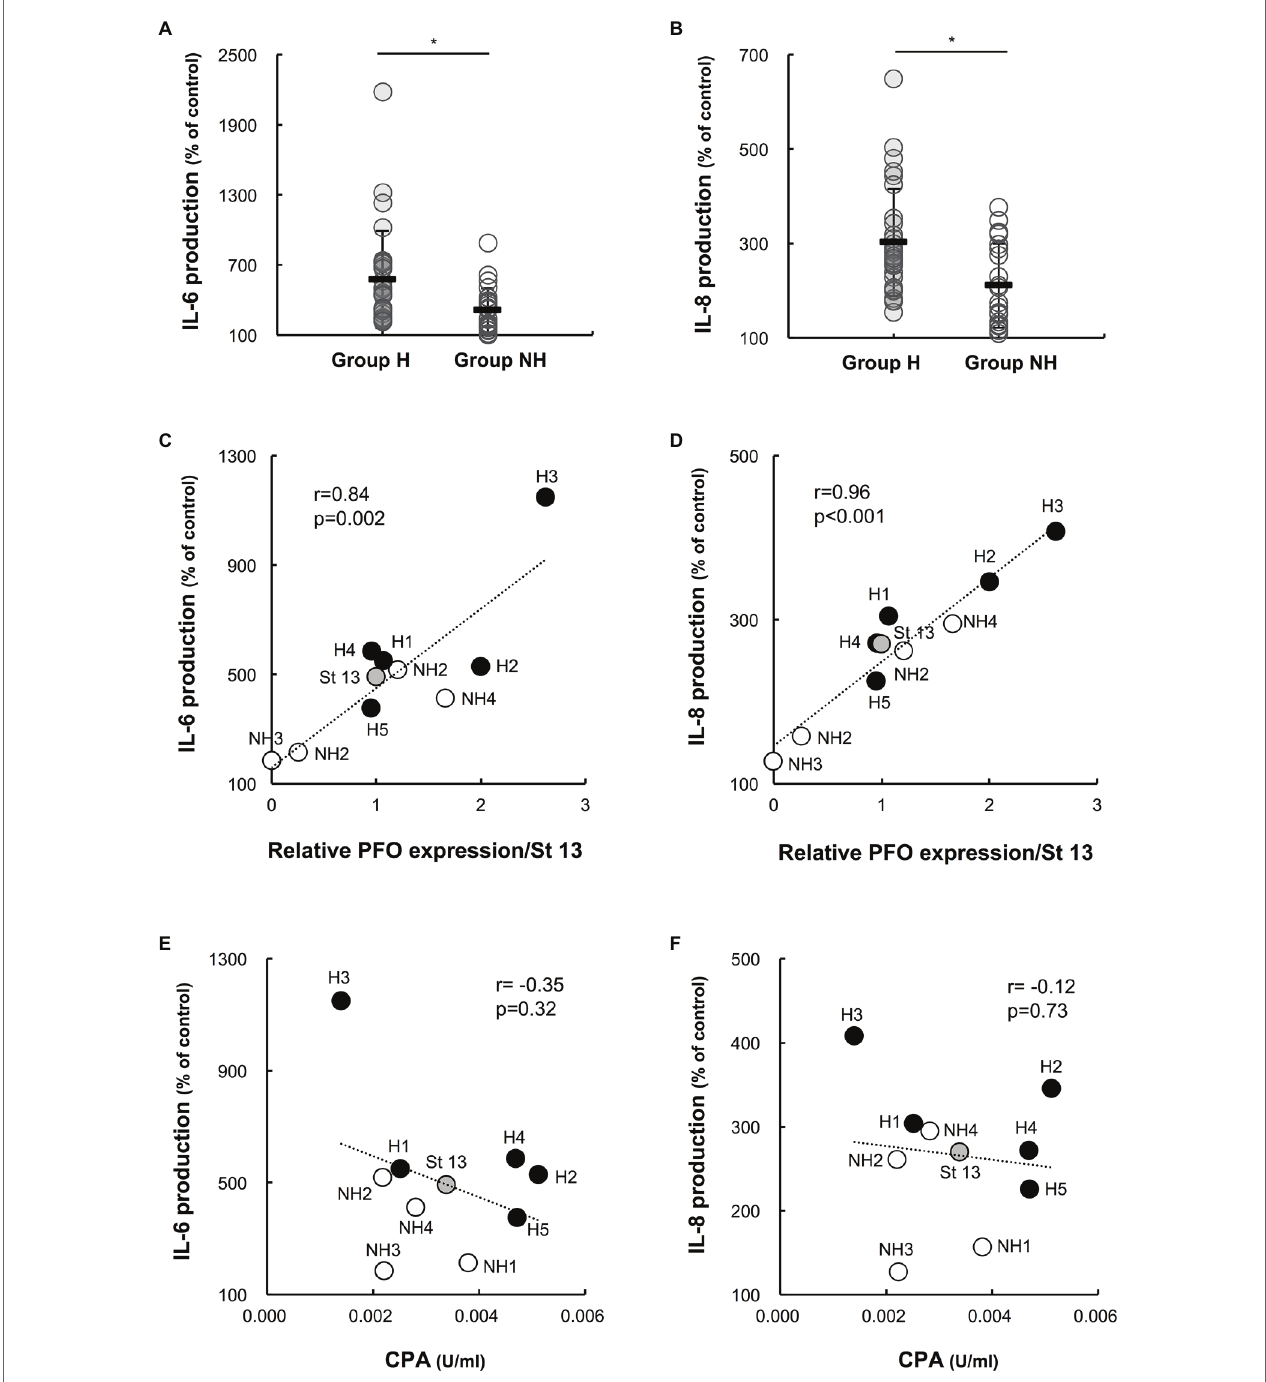
FIGURE 4 | Interleukin-6 (IL-6) and interleukin-8 (IL-8) production by PBMCs induced by supernatants of clinical isolates. Human PBMCs collected from five healthy volunteers on the day of the experiment were stimulated with 1% supernatants of clinical isolates for 4 h. Gifu anaerobic medium (GAM) broth (1%) was used as the control. The graphs show the percentages of IL-6 (A) and IL-8 (B) production normalized to the PBMC count in group H ( n = 25) and group NH ( n = 20) compared to the control. * p < 0.01 (C) Correlation between IL-6 production and PFO expression. The average amount of IL-6 produced in five healthy donors is plotted against relative PFO expression normalized to that of strain 13. (D) Correlation between IL-8 production and PFO production. The average amount of IL-8 produced in five healthy donors is plotted against relative PFO expression normalized to that of strain 13. (E) Correlation between IL-6 production and CPA production. The average amount of IL-6 produced in five healthy donors is plotted against CPA production. (F) Correlation between IL-8 production and CPA production. The average amount of IL-8 produced in five healthy donors is plotted against CPA